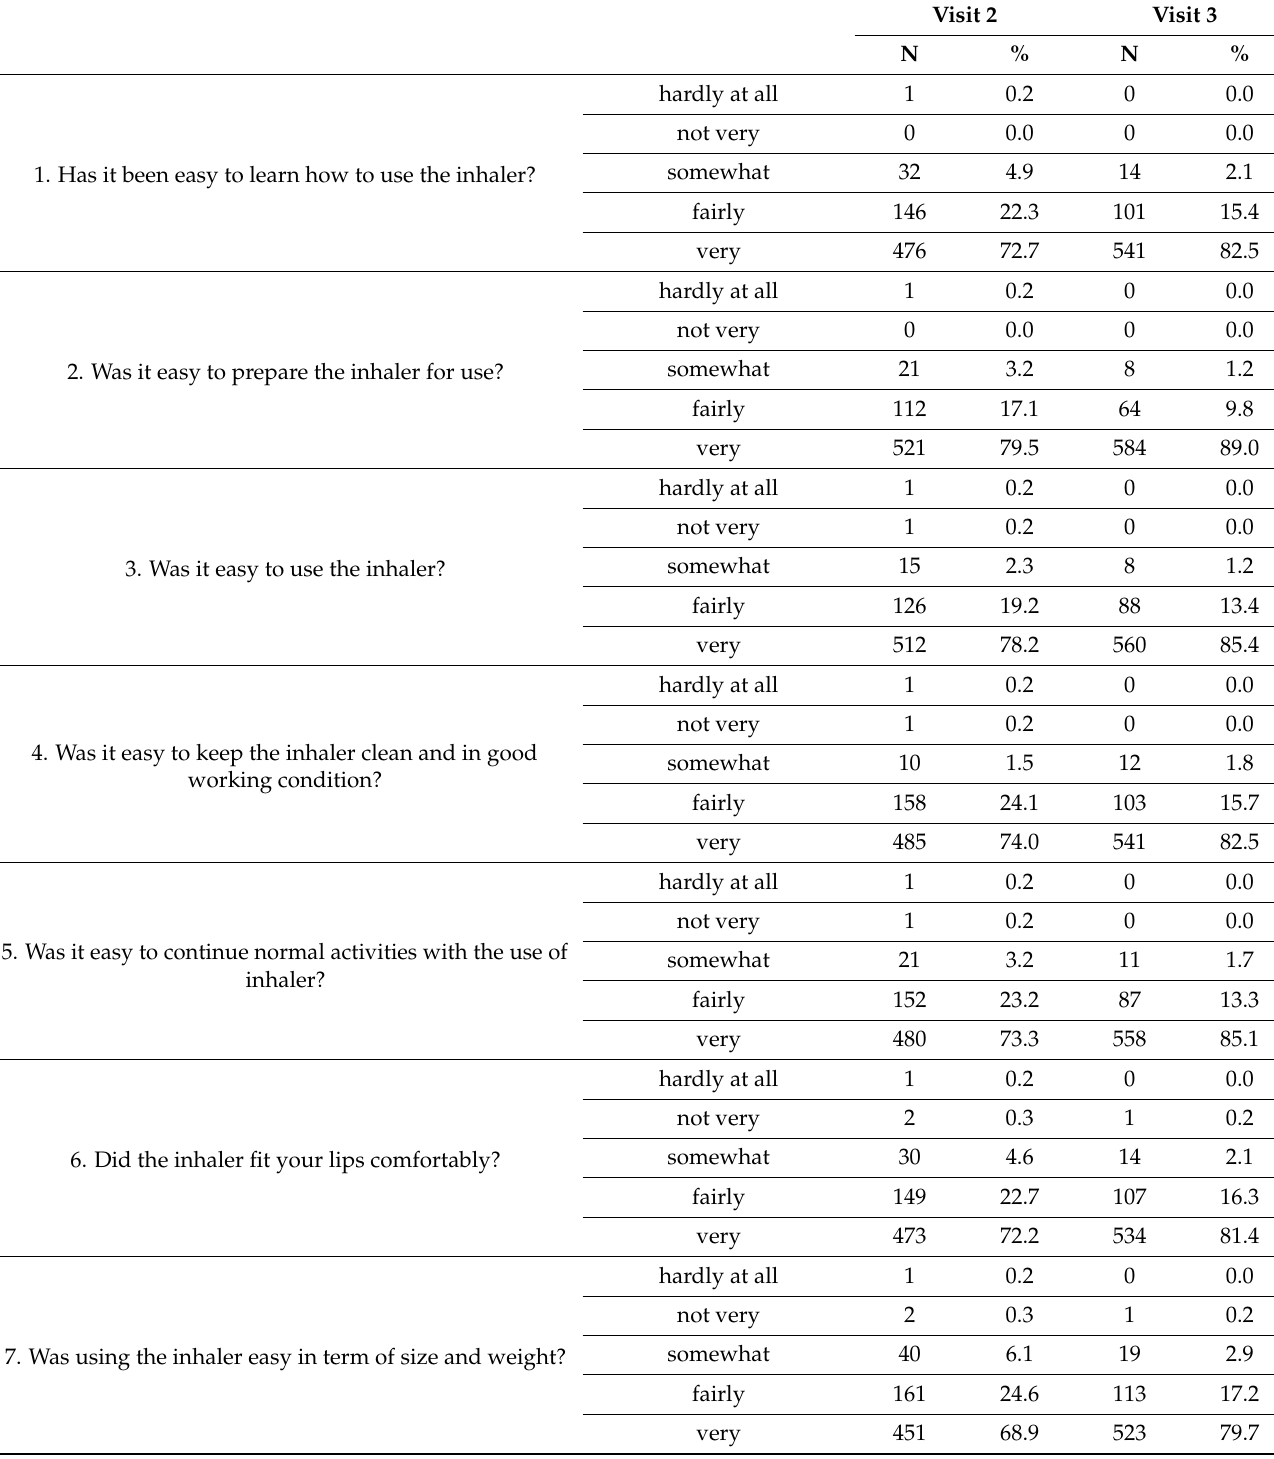
Table 2. FSI-10 Questionnaire: distribution of each of the 10 items during the two visits after baseline. Visit 2 Visit